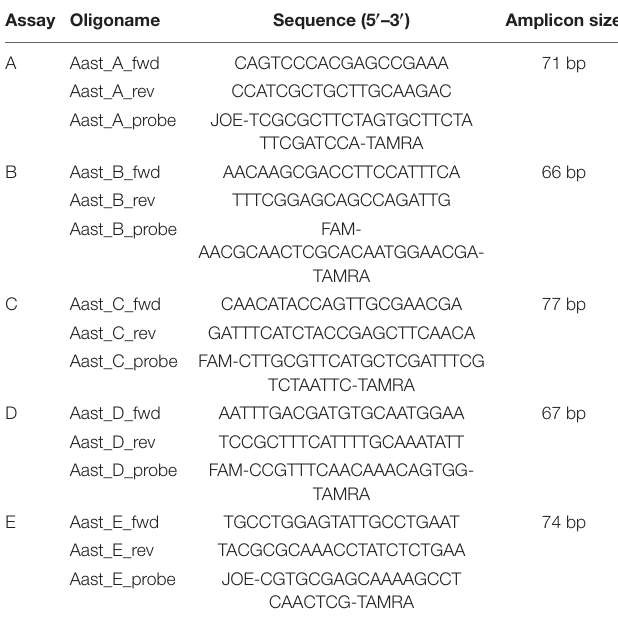
TABLE 1 | Sequences of primers and probes for the real-time PCR assays designed to amplify specific genomic regions of strains representing Aphanomyces astaci genotype groups A–E. Assay